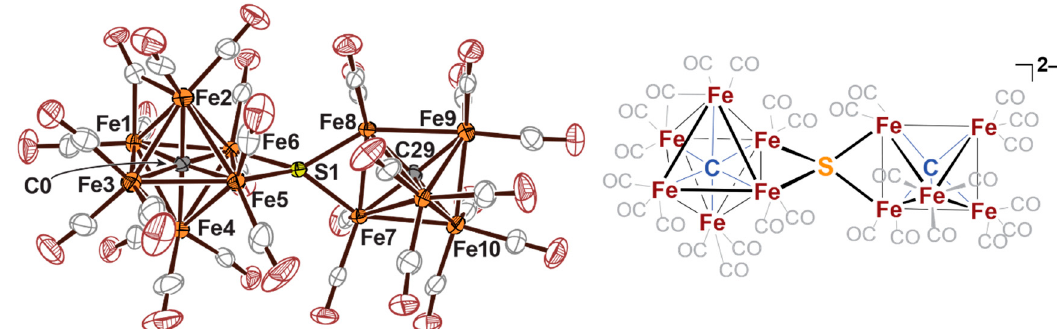
Figure 8. Thermal ellipsoid plots (50% probability) of (NEt 4 ) 2 {[(CO) 15 ( µ 6 -C)Fe 6 ]( µ 4 -S)[Fe 5 ( µ 5 -C)(CO) 13 ]} ( 3 ). Orange = Fe, Gray = C, Yellow = S, Maroon = O. Two NEt 4+ cations have been removed for clarity. Image adapted with permission from Joseph, C., Cobb, C. R., Rose, M. J. Single-Step Insertion of Sulfides and Thiolate into Iron Carbide-Carbonyl Clusters: Unlocking the Synthetic Door to FeMoco Analogues. Angew. Chemie Int. Ed. 2020 , Accepted, not yet published . Copyright Wiley-VCH GmbH . Reproduced with permission.